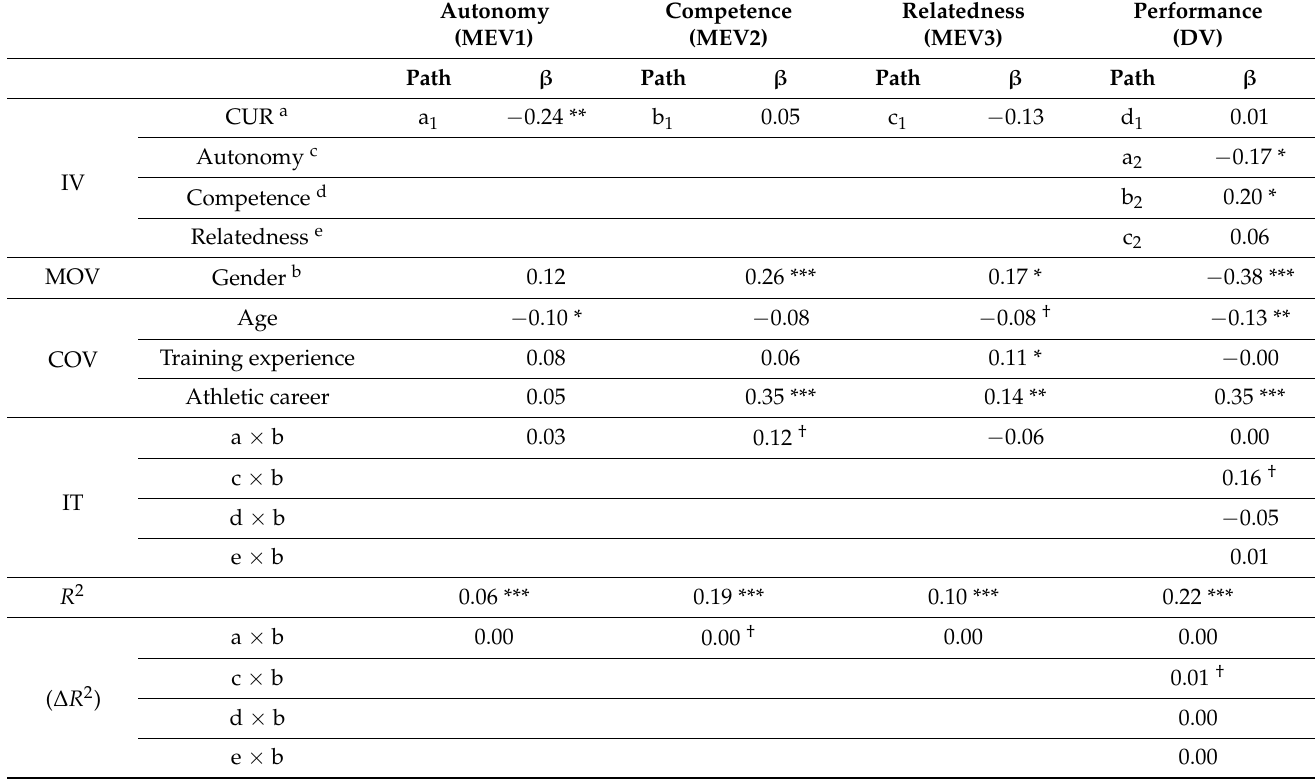
Table 2. Regression coefficients and model summary information for multi mediated moderation (IV =